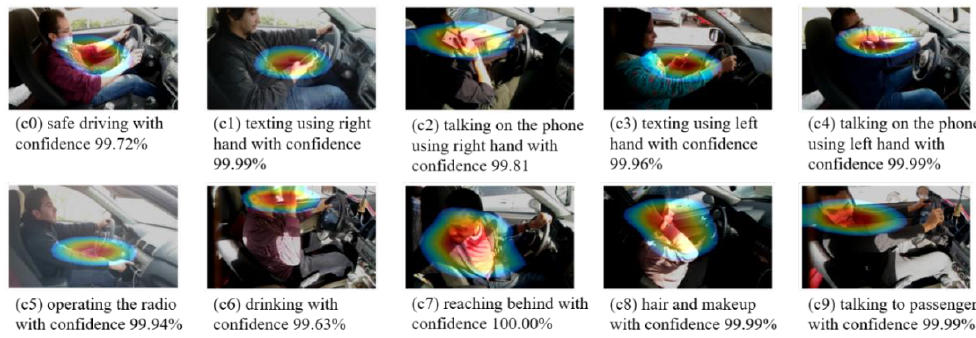
Figure 2. Grad-CAM activation maps of various distracted driving behaviors in the dataset.